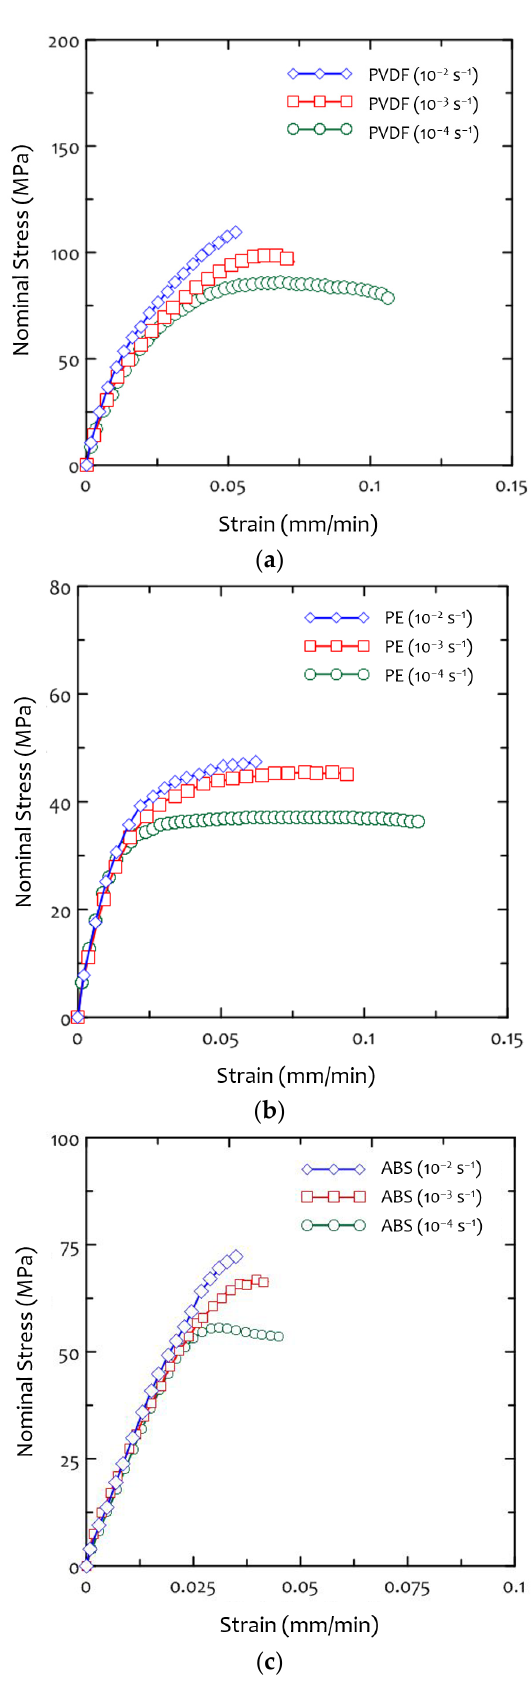
Figure 7. Strain-rate-dependent stress-strain curves of the polymers at − 50 °C: ( a ) PVDF, ( b ) PE, and ( c ) ABS.